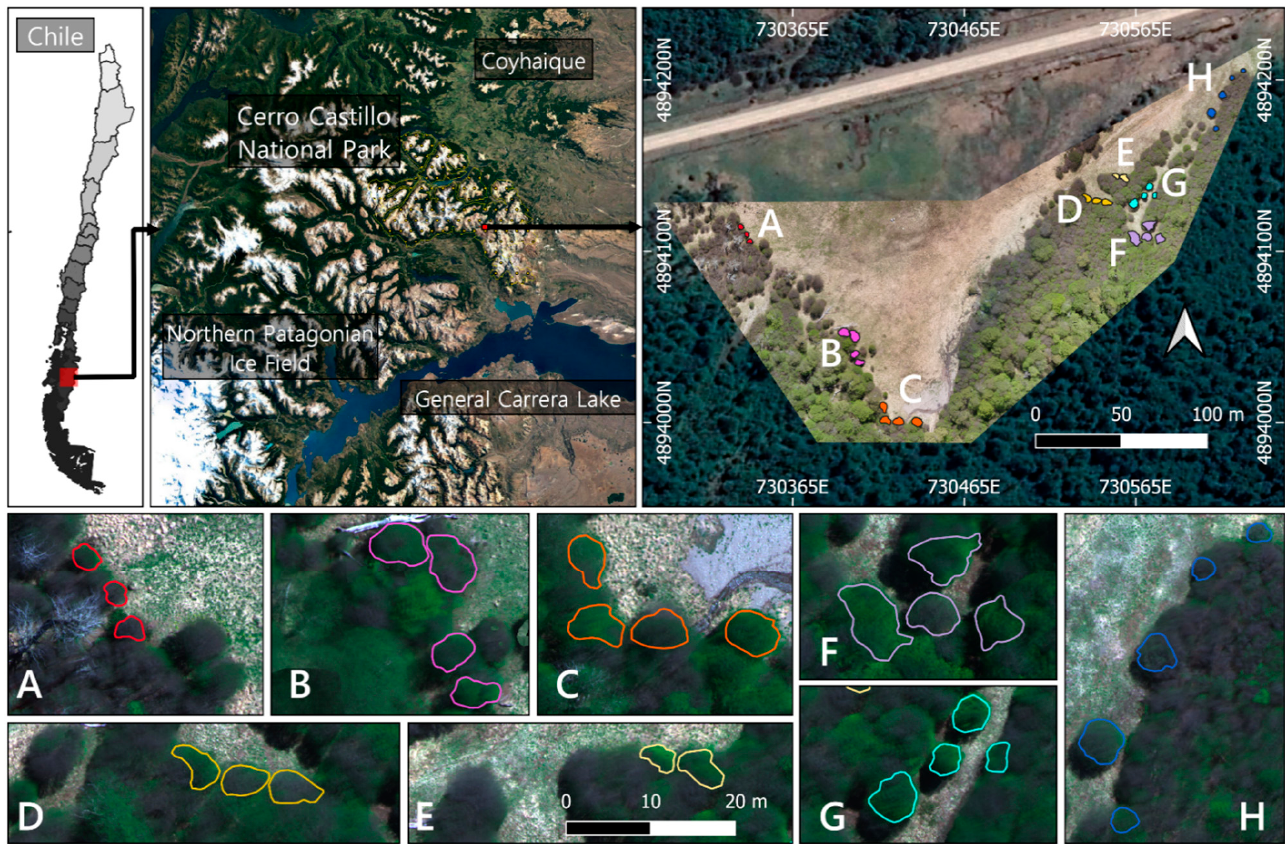
Figure 1. Study area in Cerro Castillo National Park. The different sampling sites are specified with an approximate area of recollection ( A – H ). ( D , E ) are two sample sites representing direct and indirect sunlight exposure, respectively.